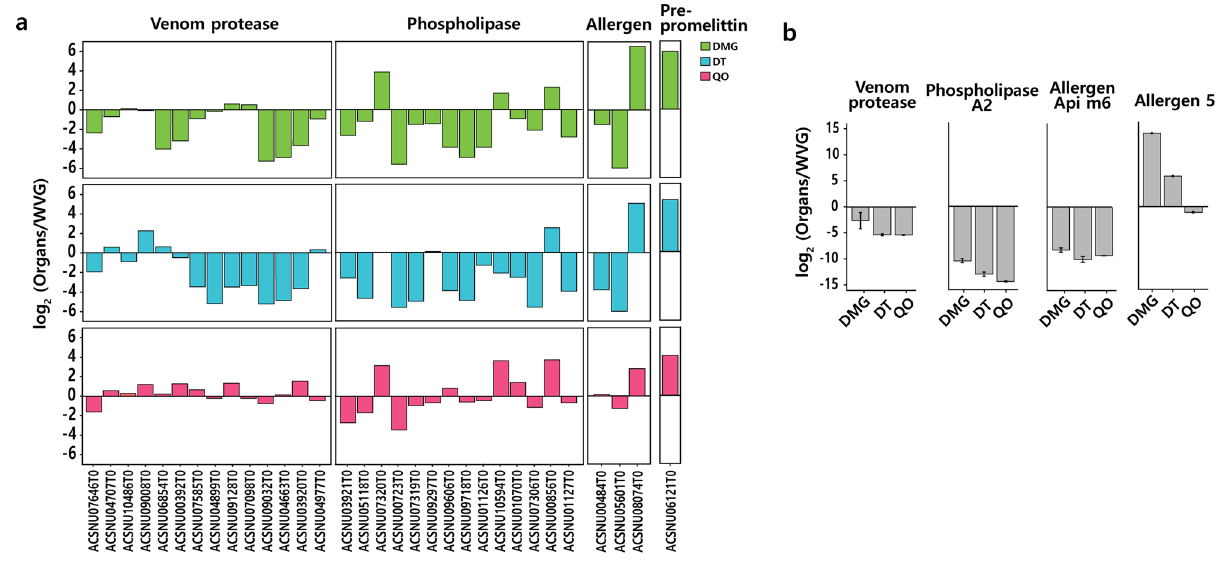
Figure 7. Expressions differences of venom-specific genes among reproductive organs. ( a ) Values above zero indicated greater relative transcript abundance in reproductive organs compared that of to the venom gland. Genes were differentially expressed at a p -value < 0.05. ( b ) Relative expressions of venom-specific genes exhibiting significant change. DMG drone mucus gland, DT drone testis, QO queen